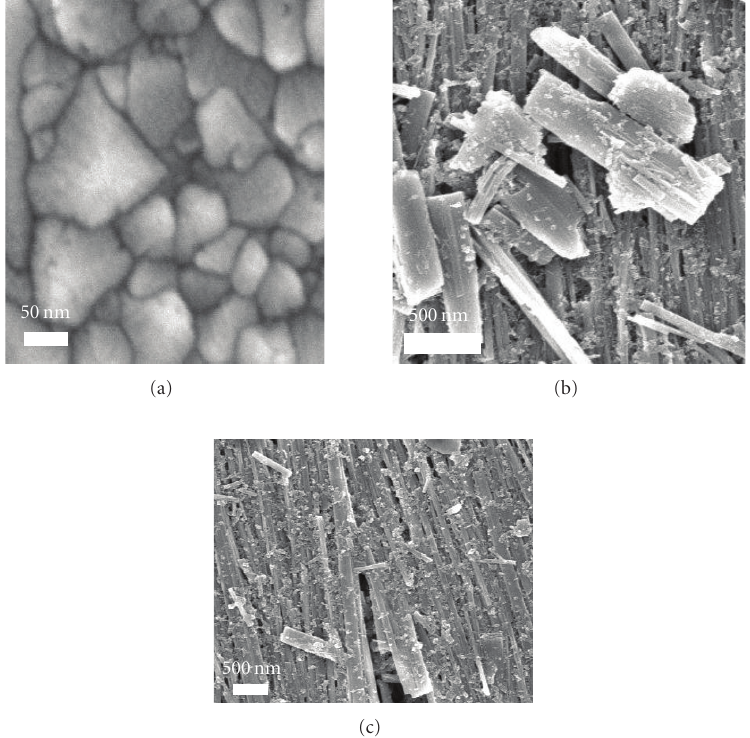
Figure 2: SEM images of FTO glass (a) and TNR films deposited for (b) 1min and (c) 3 min.